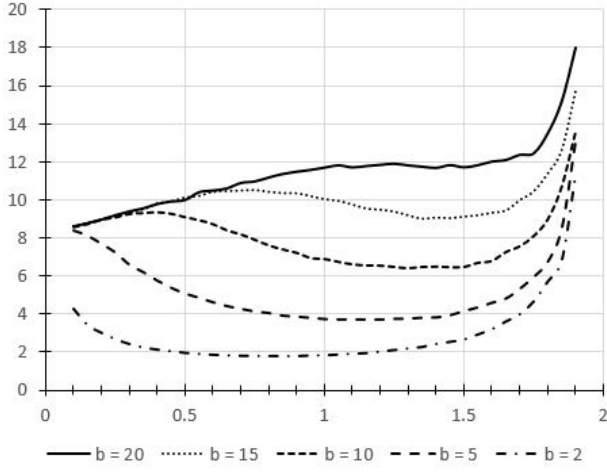
Figure 21. System eesponse time vs. arrival rate of requests for various values β of the batch sizes for Urgent